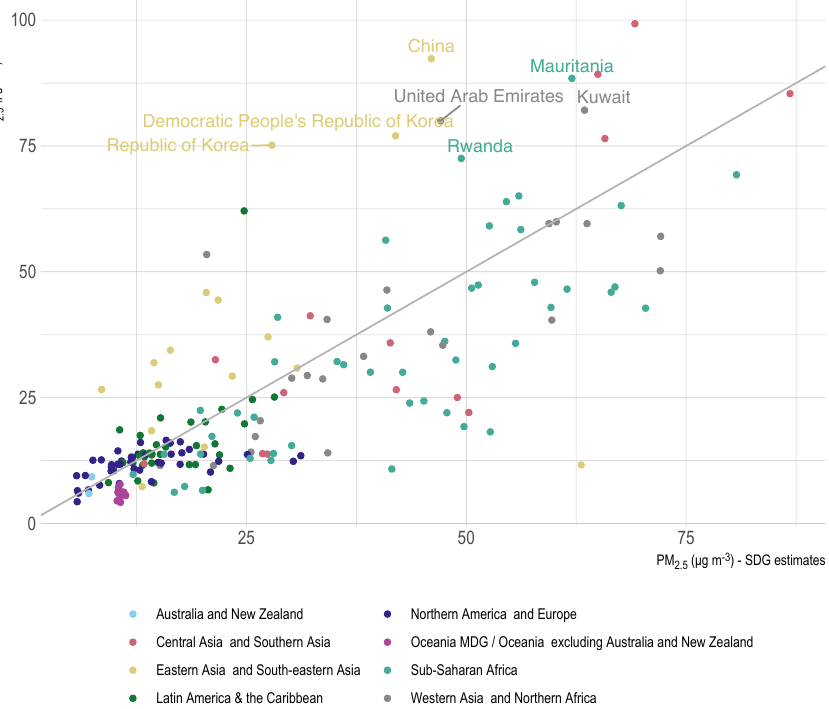
Figure 3. Comparison between the country-level population-weighed annual average of PM 2.5 estimated by the Copernicus Atmosphere Monitoring Service multi-annual global reanalysis of atmospheric composition and SDG indicator 11.6.2 calculated using DIMAQ, by SDG region, for 2016. Grey line indicates a one-to-one